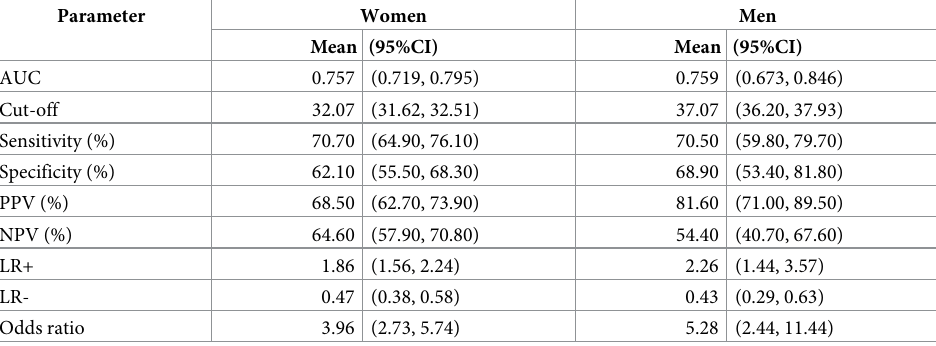
Table 4. Predictive validity of neck circumference in identifying NAFLD, stratified by gender.